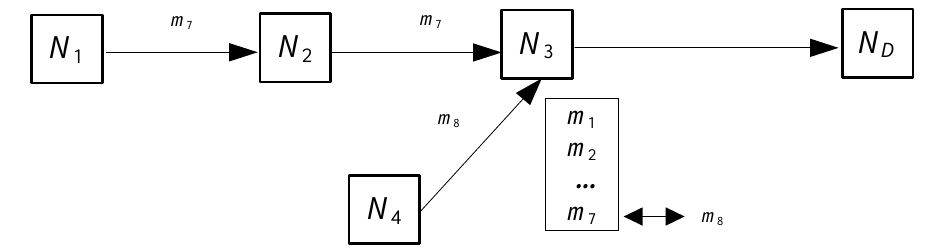
Figure 1. Discarding message due to congestion.